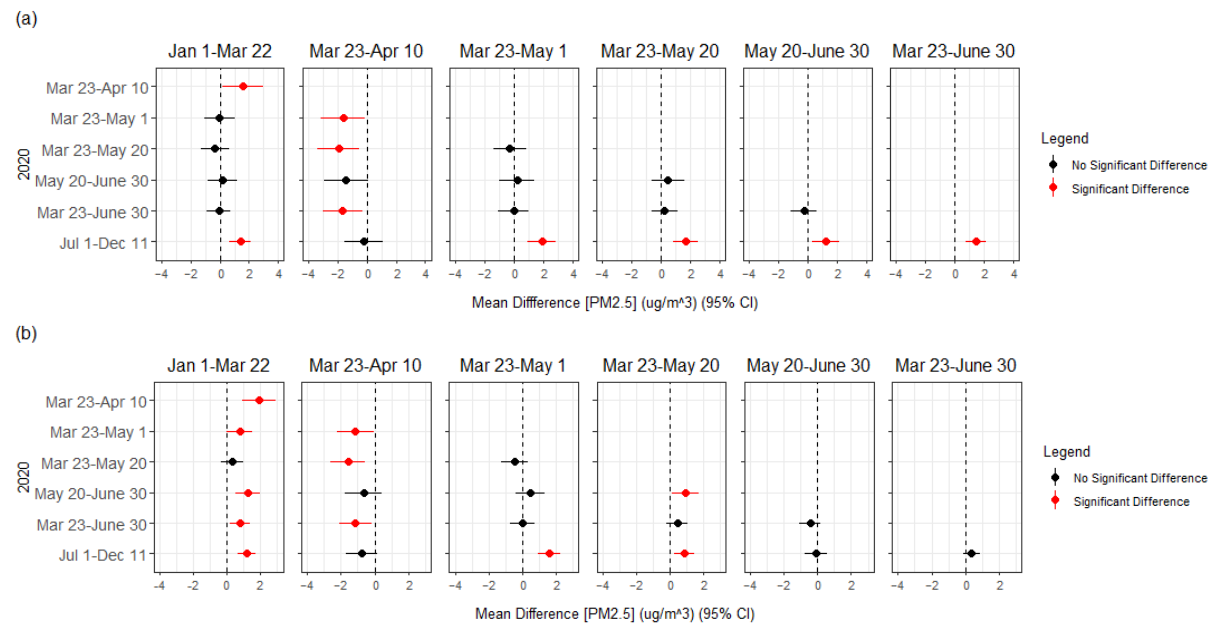
Figure 13. Boxplots of hourly O 3 during each time period of interest during 2020 at the Taft site.